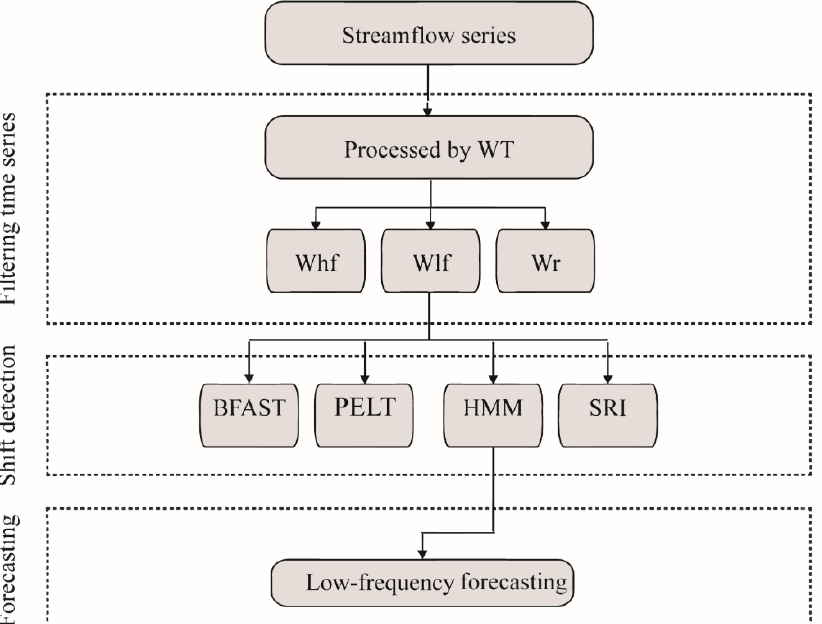
Figure 2. Flowchart of the procedure applied in the study describing the steps of the shift detection and projection model. The time series is filtered using wavelet transform (WT) into the high-frequency (Whf), low-frequency (Wlf), and residue (Wr) components.